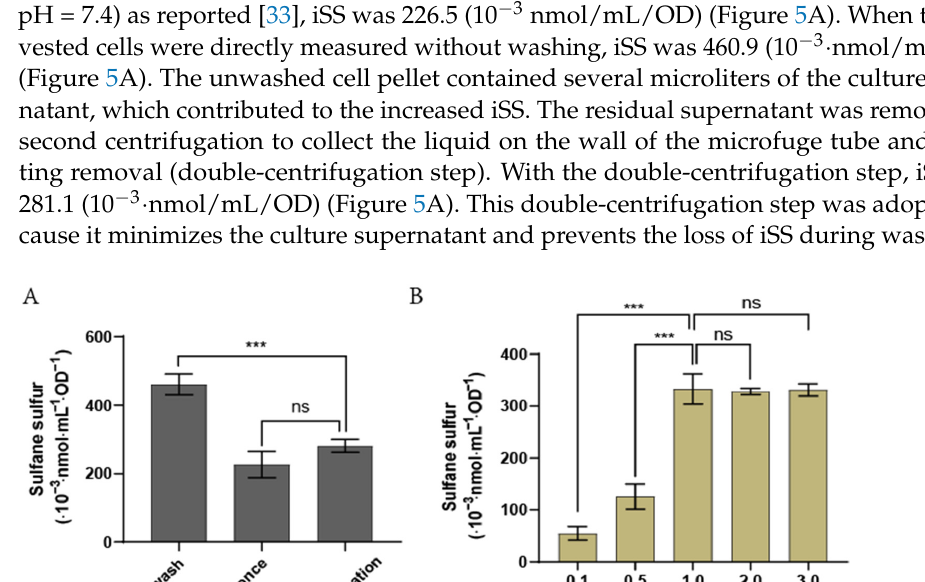
Figure 4 . The addition of DTT in the control buffer prevented iSS formation from self-oxidation . ( A ) S 2 O 32 − detected from 3 mL of E. coli BL21(DE3) cells at OD 600 of 1.0 resuspended in the control buffer with different amounts of DTT. ( B ) DTT did not reduce the amount of S 2 O 32 − . 10 μ M S 2 O 32 − was dissolved in the control buffer with different amounts of DTT and heated at 95 °C for 10 min. The quantity of S 2 O 32 − was determined after mBBr derivatization. Three parallel experiments were performed to obtain the averages and standard deviations (n = 3). The one-way ANOVA method was performed to calculate the p -values (Not significance (ns), p ≥ 0.05; ***, p < 0.001). Whether it is necessary to remove the residual culture supernatant before iSS deter- mination was tested. Sulfane sulfur in the supernatant fluctuated around 23 μ M without significant changes during the growth of E. coli BL21(DE3) in the LB medium (Figure S1). When the harvested cells by centrifugation were washed once with Tris-HCl buffer (50 mM, pH = 7.4) as reported [33], iSS was 226.5 (10 − 3 nmol/mL/OD) (Figure 5A). When the harvested cells were directly measured without washing, iSS was 460.9